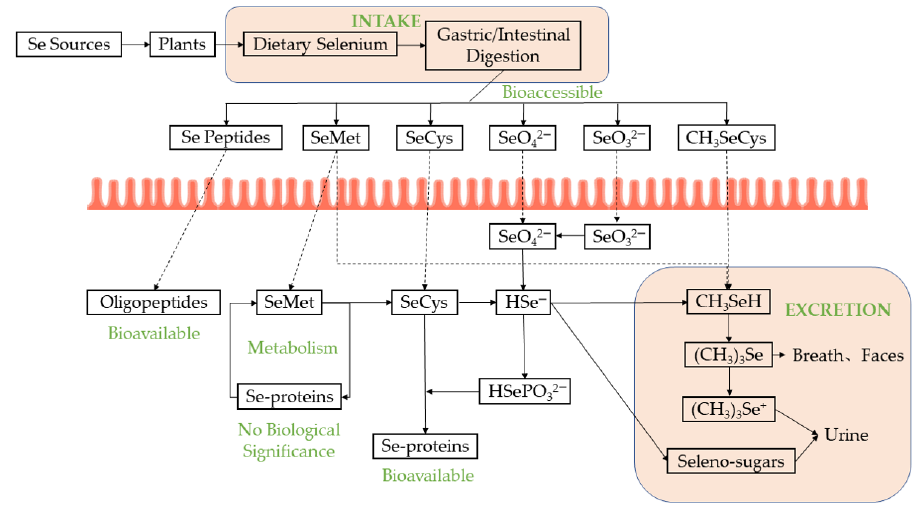
Figure 1. Absorption and metabolic pathways of selenium in humans [2,4,5].